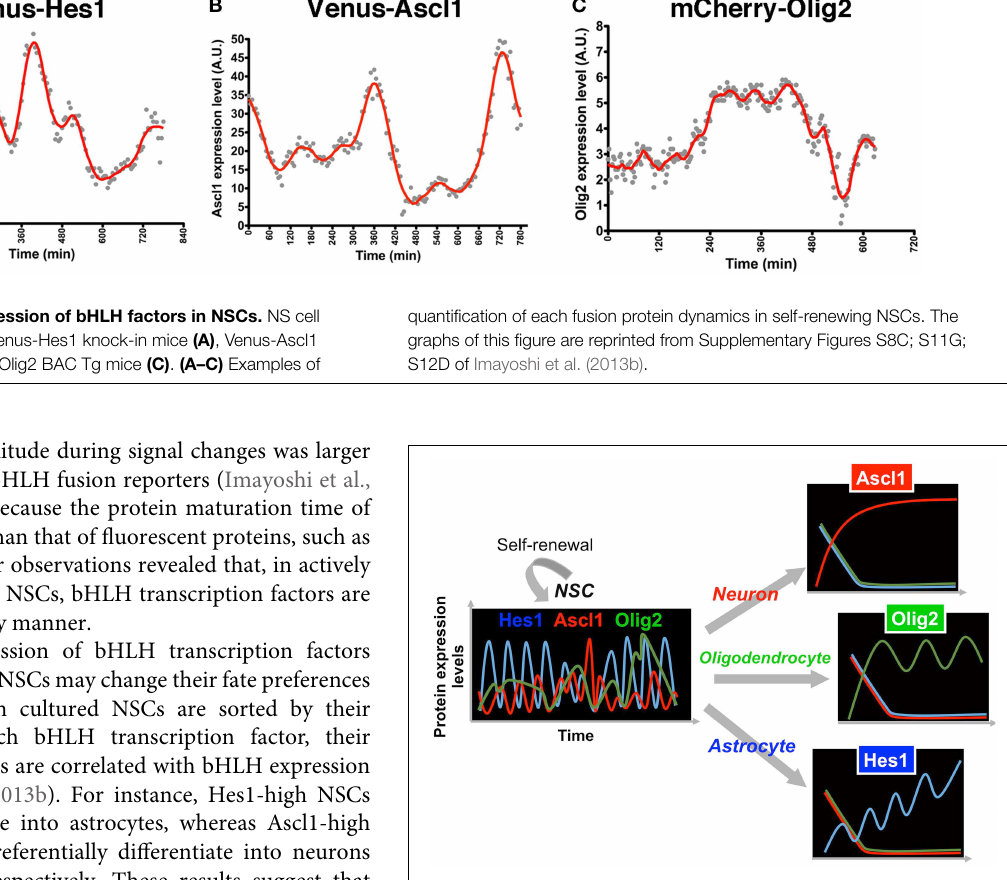
FIGURE 3 | Expression dynamics of bHLH factors in multipotency and cell fate choice. In multipotent NSCs, the levels of Hes1 and Ascl1 oscillate with periods of 2–3h, while that of Olig2 oscillates with a period of 5–8h. By contrast, during cell fate choice, one of the bHLH factors is expressed in a sustained manner, while the others are